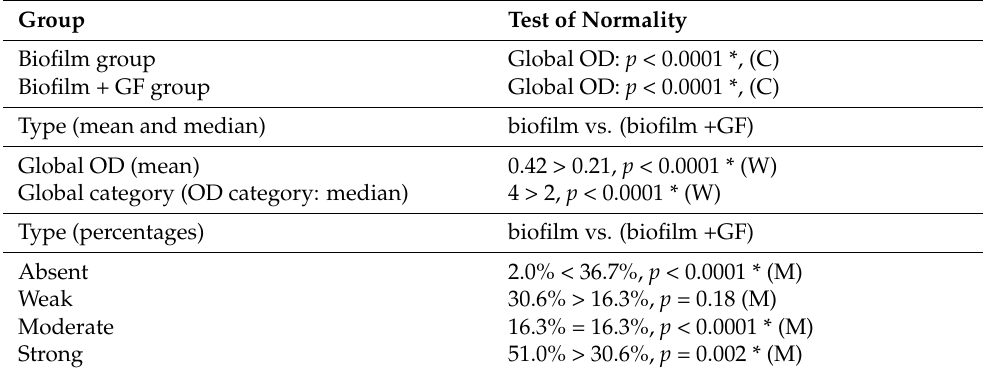
Table 4. Statistical tests to compare the biofilm and biofilm + GF groups and their normality test. Group Test of